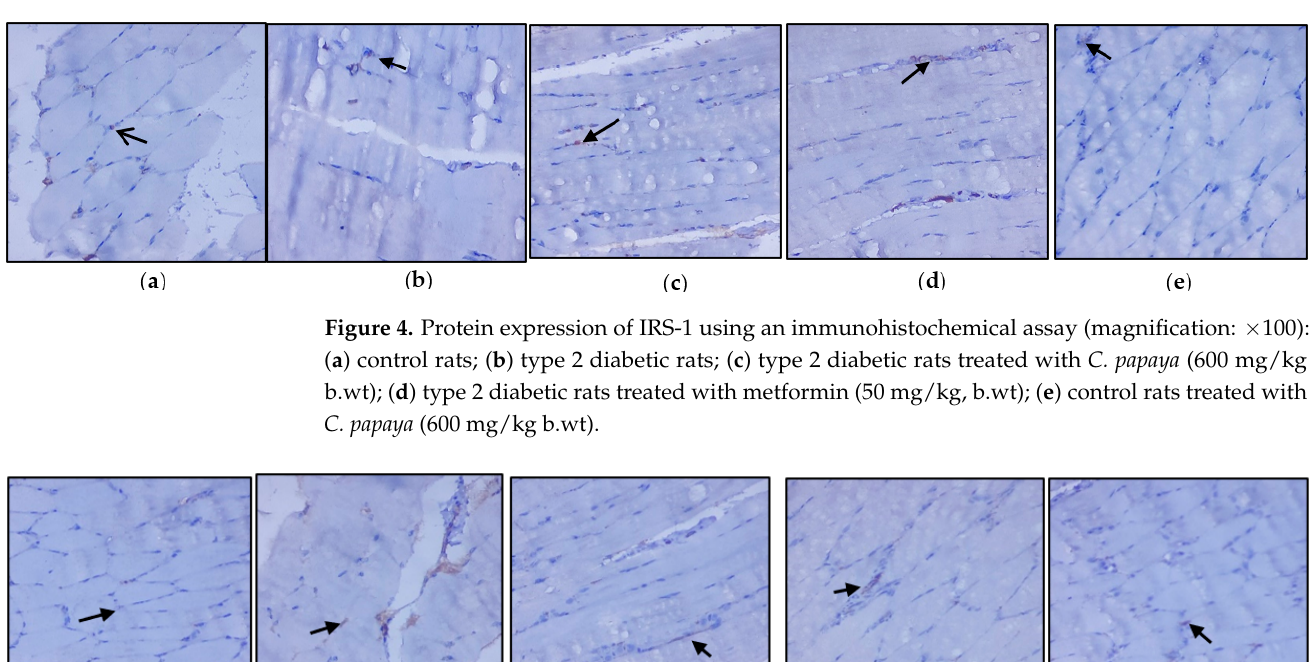
Table 3. Binding affinity assessment based on docking score of proposed natural compounds and selected target proteins. S. No Compound Name Lig Score1_Drei ding